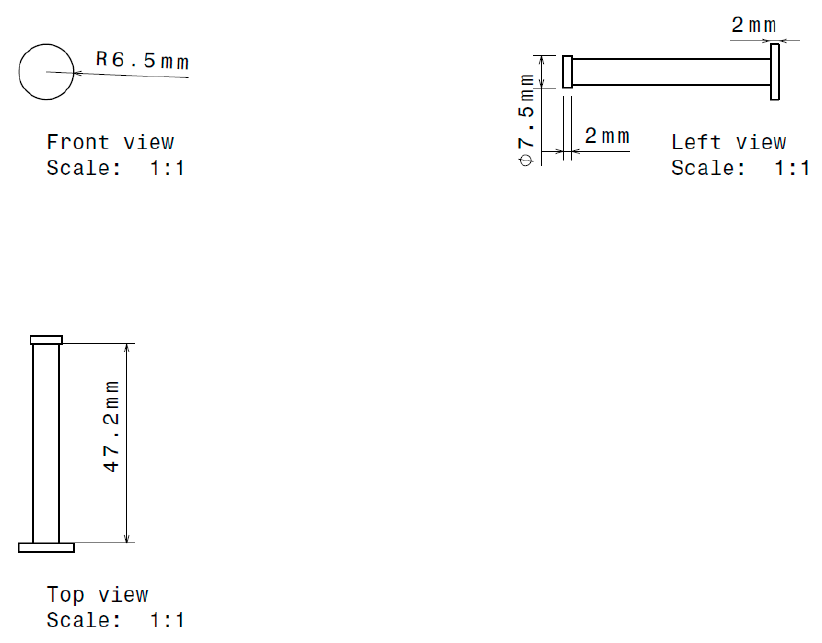
Figure 6. The dimensions of the axis pin.